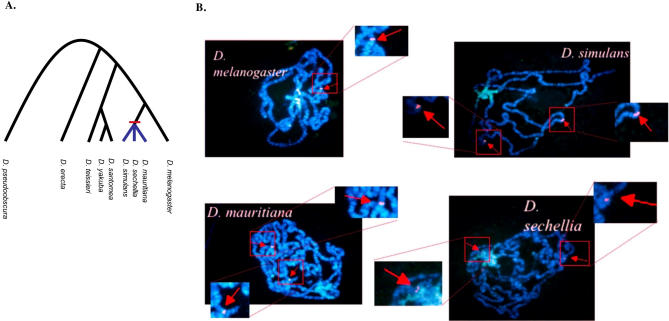

D. melanogaster Subgroup Phylogeny with the Hun Duplication Mapped onto It as Informed by FISH(A) D. melanogaster phylogeny with Drosophila pseudoobscura as the out-group. Red bar indicates Hun duplication, with blue branches below it noting the species in possession of it.(B) FISH was carried out on the D. melanogaster subgroup. Probe signals are indicated by the red arrows. The two signals found in D. sechellia, D. mauritiana, and D. simulans indicate the Hun duplication. Only one signal is found in D. melanogaster, the out-group in this figure, as well as for all other species in the subgroup. FISH images for full subgroup will be provided upon request.